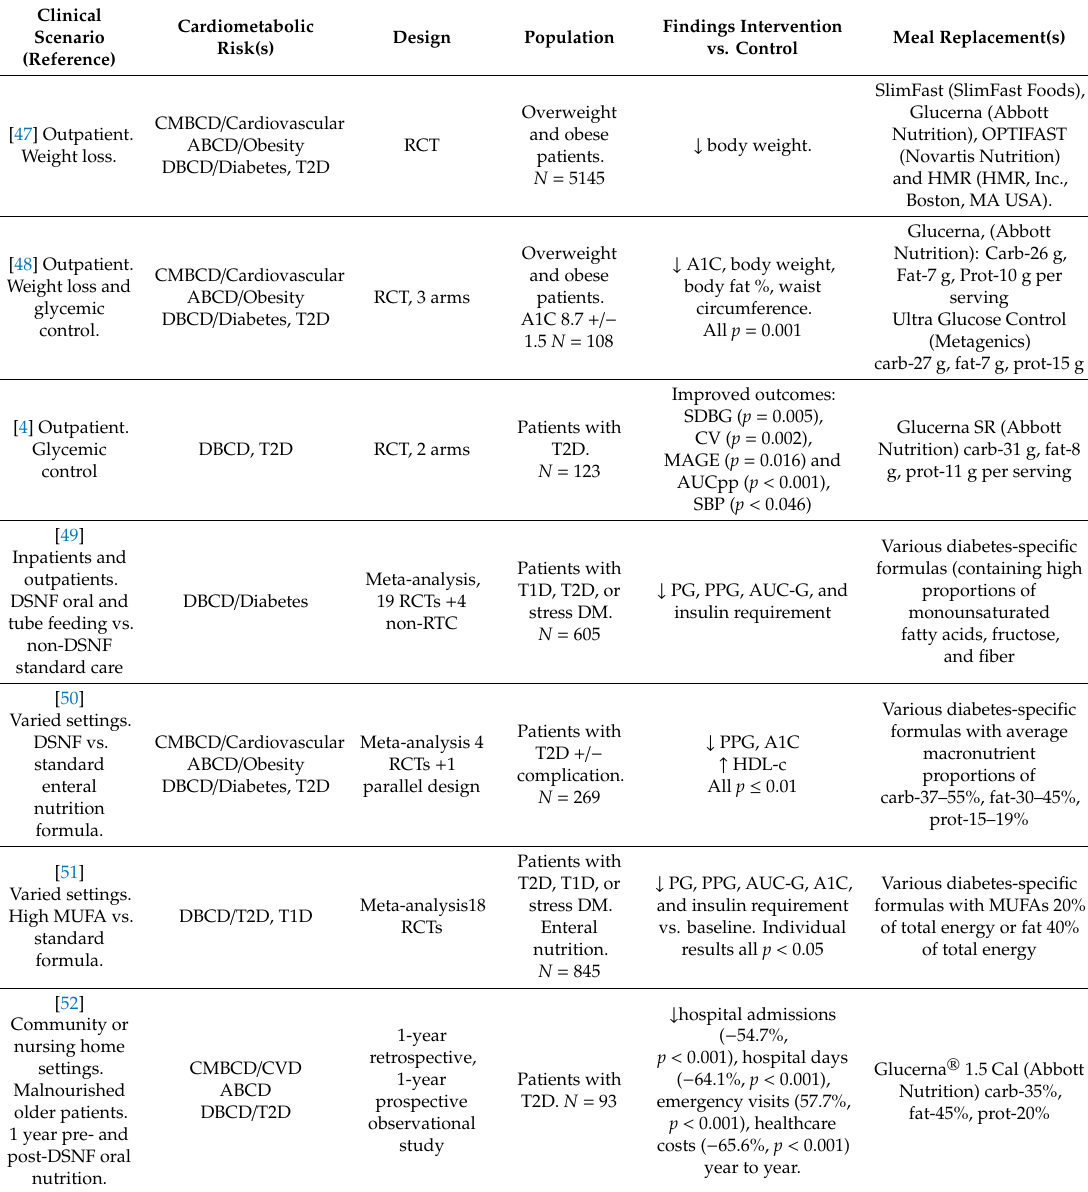
Table 3. Diabetes-specific nutrition formula (DSNF) studies in various diabetes and cardiometabolic clinical